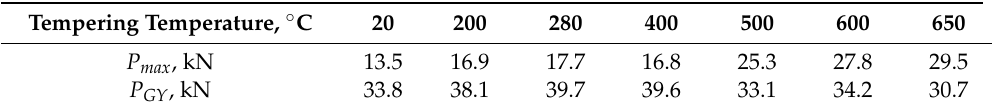
Table 2. The P max from Charpy load–deflection curves and calculated P GY for the 0.4%C-1.6%Si- 1%Cr-0.95%Mo steel with V and Nb after quenching from 900 ◦ C into water and tempering at different temperatures. Tempering Temperature, ◦ C